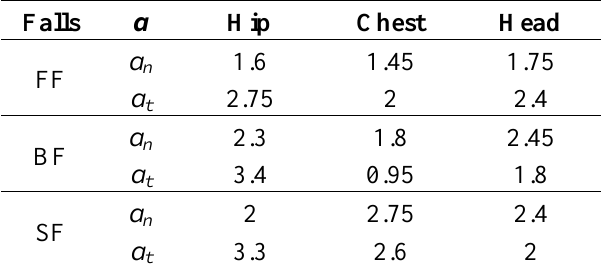
Table 4 ( a = 2.7 g, a = 4.7 g) should trigger the threshold sensor, while 50% of this signal ( a n t = 2.75 g) in Table 6, representing the ADL, will not trigger the threshold sensor. a t Table 6. 50% of the fall